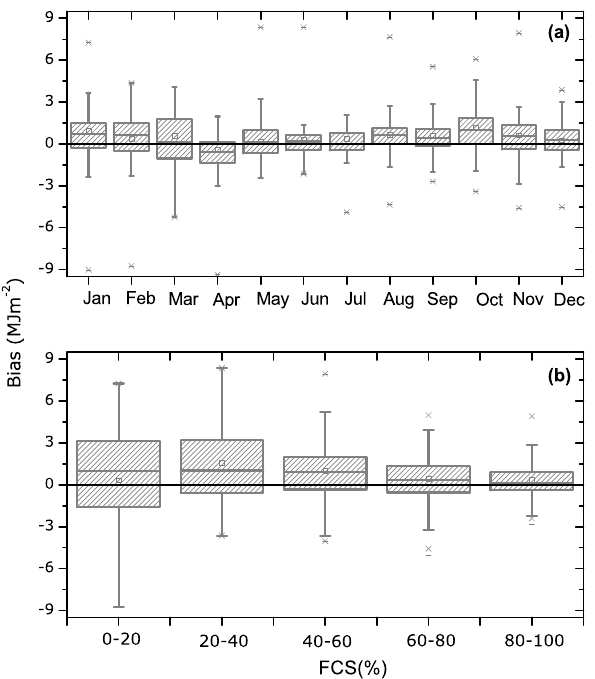
lation coefficient. The statistics for the relative bias are in brackets